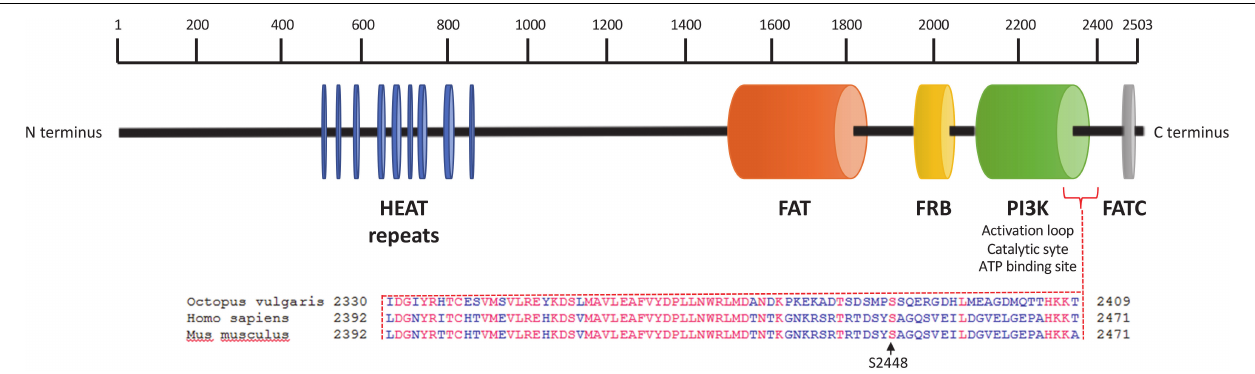
FIGURE 1 | Octopus vulgaris mTOR domain architecture and protein alignment in the region of the conserved human and mouse phosphorylation site at Ser2448. Octopus vulgaris mTOR full sequence contains about 2503 amino acids; the N-terminus comprises 9 HEAT repeat motifs (blue) followed by a FAT domain (orange). Downstream, mTOR includes a FKPB12-rapamycin binding (FRB) domain (yellow). The C-terminal contains a catalytic domain PI3K (green), with the mTORC1 activation site at Ser 2386 (conserved between octopus, human and mouse genomes), and a FATC domain (gray).